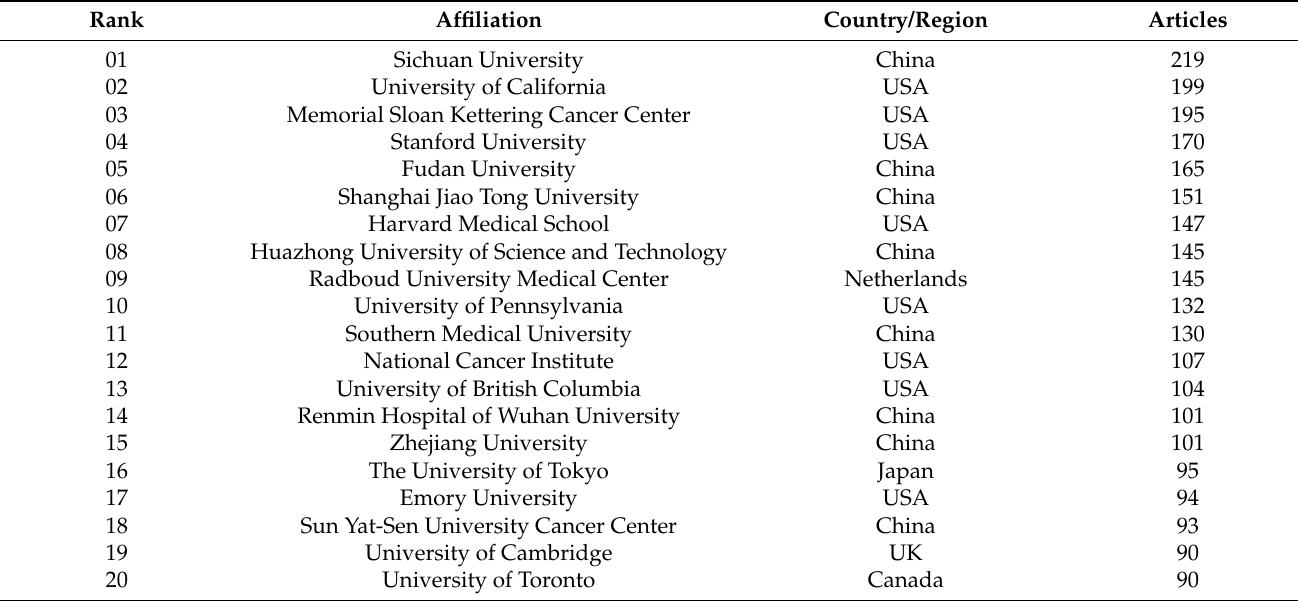
Table 6. Overview of the affiliations with the most